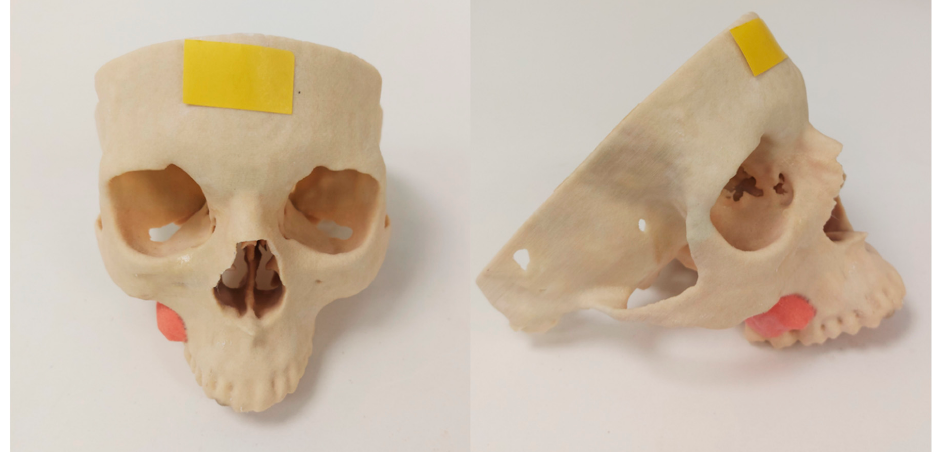
Figure 1. Visualization using 3D printing. 3D printed plaster model fabricated by multi-colored Binder-Jet 3D printing. The lesion outlined in red demonstrates osteosarcoma in the